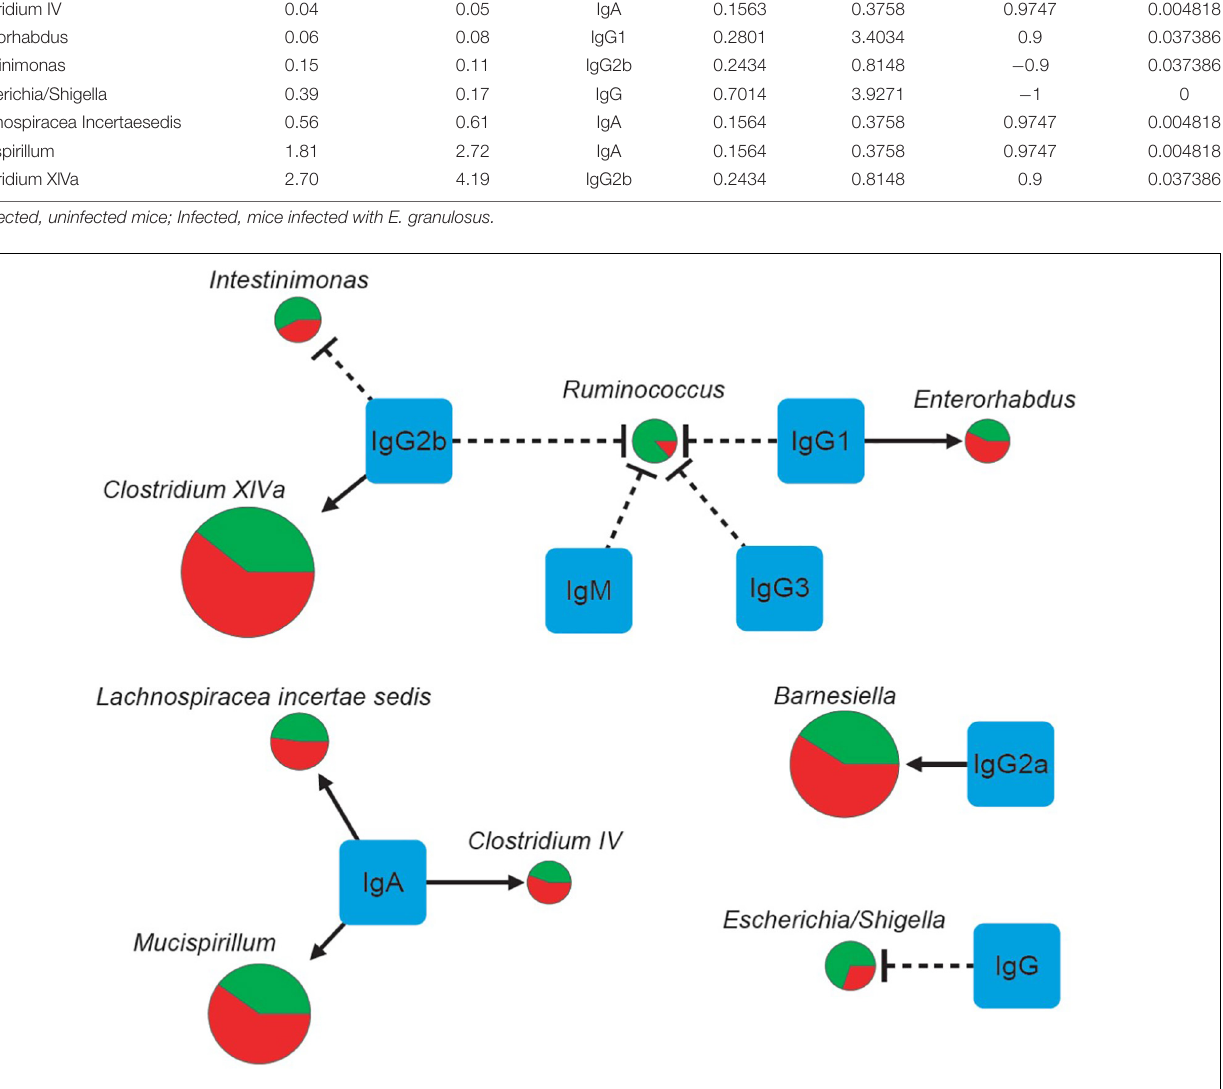
FIGURE 4 | The correlations of seven physical factors and major genera. The pie charts show relative proportions of major genera in the E. granulosus infected mice and uninfected mice. (Green: Uninfected Group; red: Infection Group), and the circle size represents the reads numbers. Line and arrow type: solid arrow (positive relations), dash “T” (negative